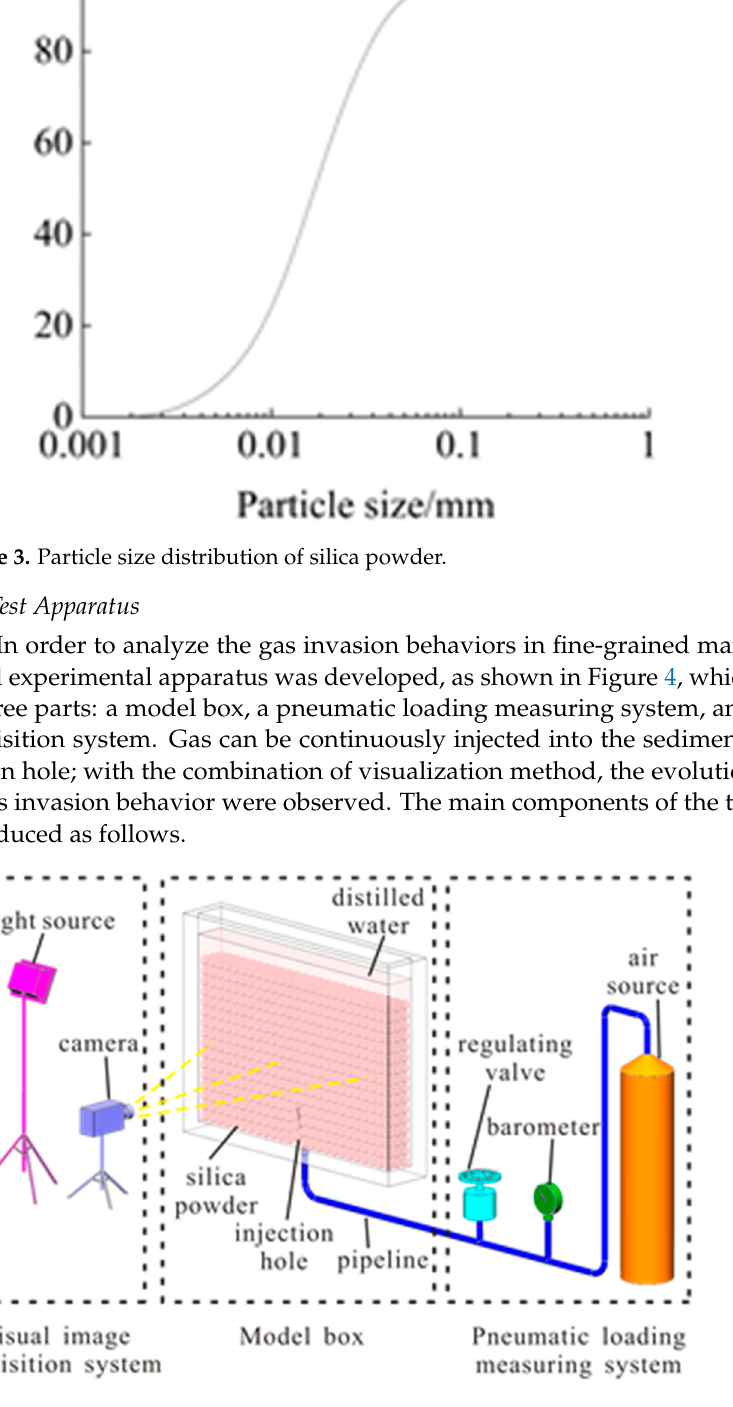
Figure 4. Schematic diagram of the test procedure for shallow gas invasion in fine-grained marine sediments.